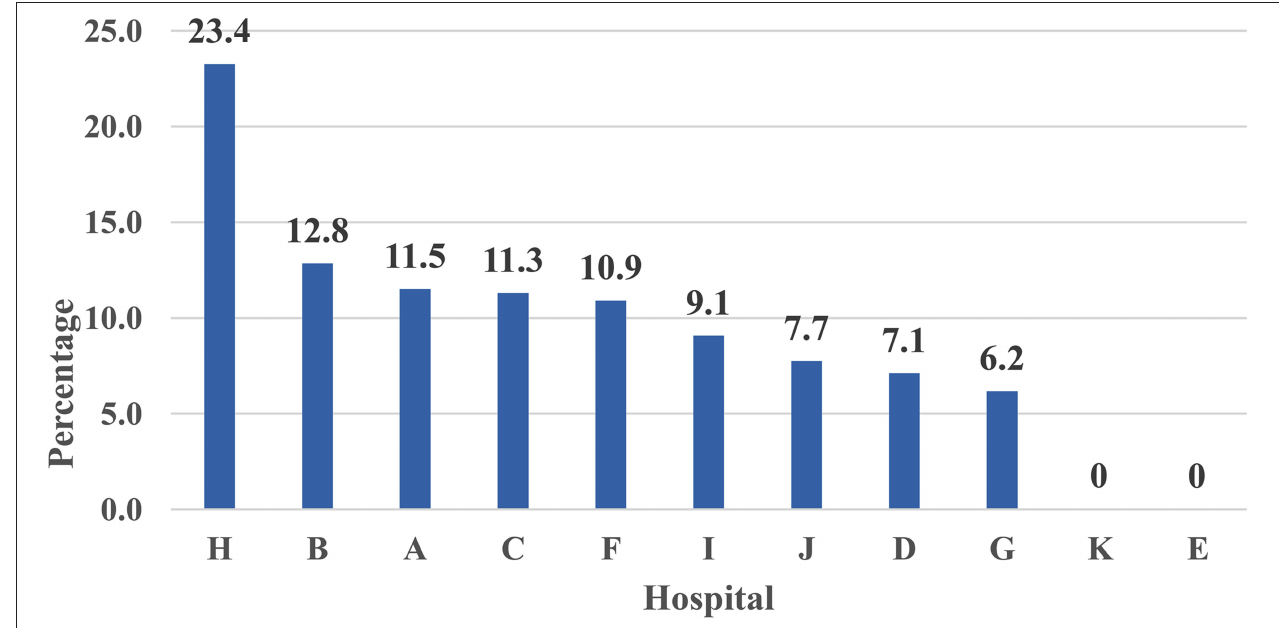
FIGURE 1 | Percent distribution of screened non-medical personnel with COVID-19 triage across 11 Teaching hospitals—Egypt: (June 1 to July 15, 2020)—Rank ordering.